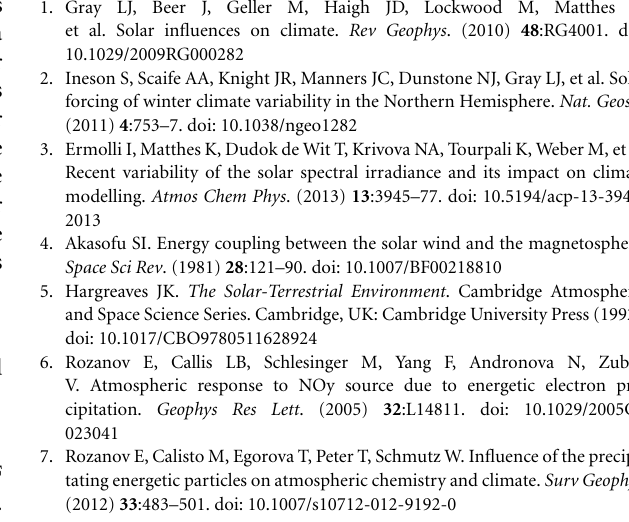
shown for ± 0 . 5, ± 1, ± 2, ± 4, ± 6, ± 8, and ± 10K. Negative values are shown in blue and indicated with additional dashing. The 90% (95%) significance levels calculated using the t -test are shown with light (dark) gray